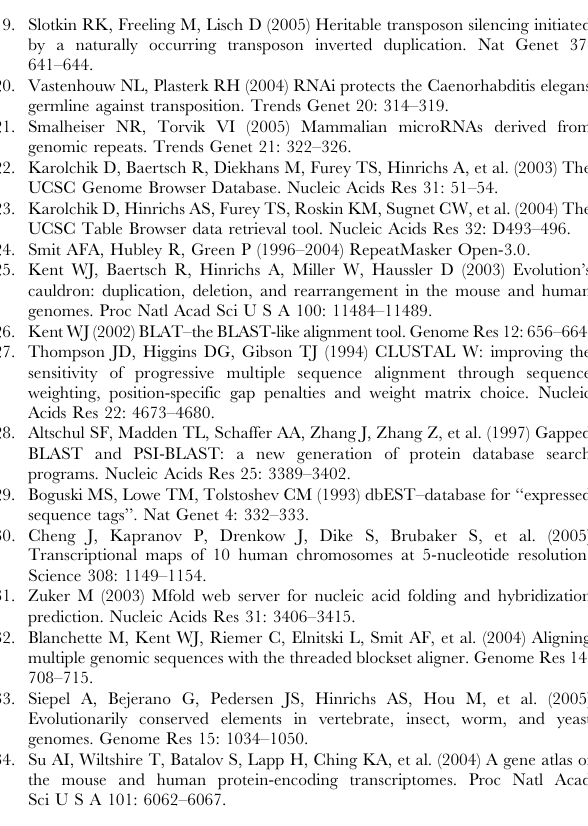
Table S2 Over-represented GO biological process categories among genes with Made1 derived hsa-mir-548 target sites. Table S3 Over-represented GO biological process categories among genes with miRanda predicted hsa-mir-548 target sites that map to colorectal cancer down-regulated co-expression clusters (i.e. 12, 15 & 20 in Figure 6). Table S4 Putative hsa-mir-548 target genes previously implicat- ed as being involved in colorectal cancer by microarray expression